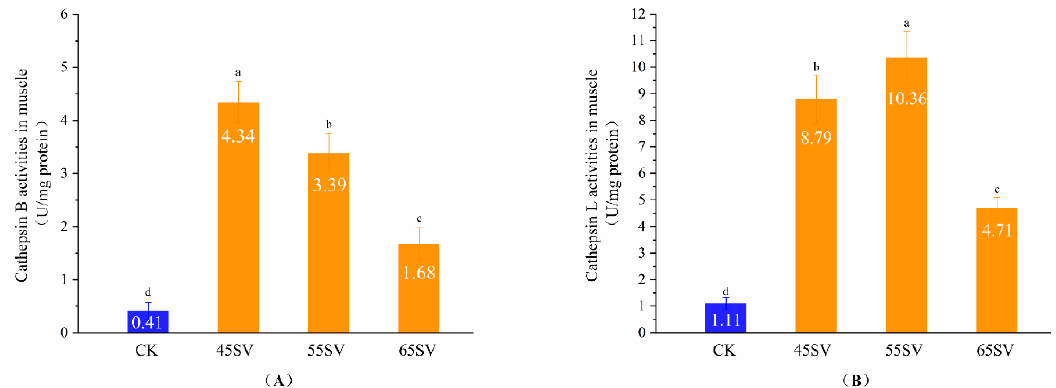
Figure 2. Cathepsin B ( A ), Cathepsin L ( B ) activity in muscle of CK and SV with different temperature. Different letter (a–d) statistically indicates the significant differences on the activity of cathepsin B ( p < 0.05, n = 5).